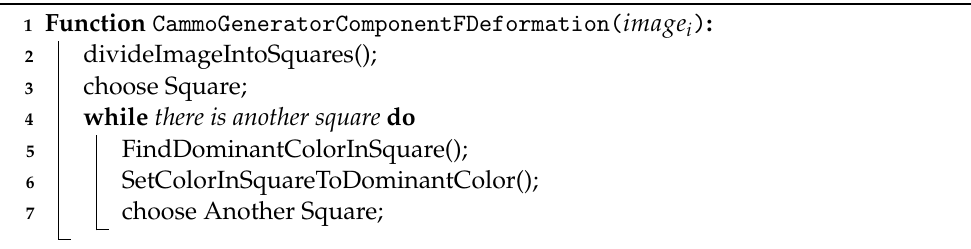
Algorithm 3: CammoGenerator component—deformation